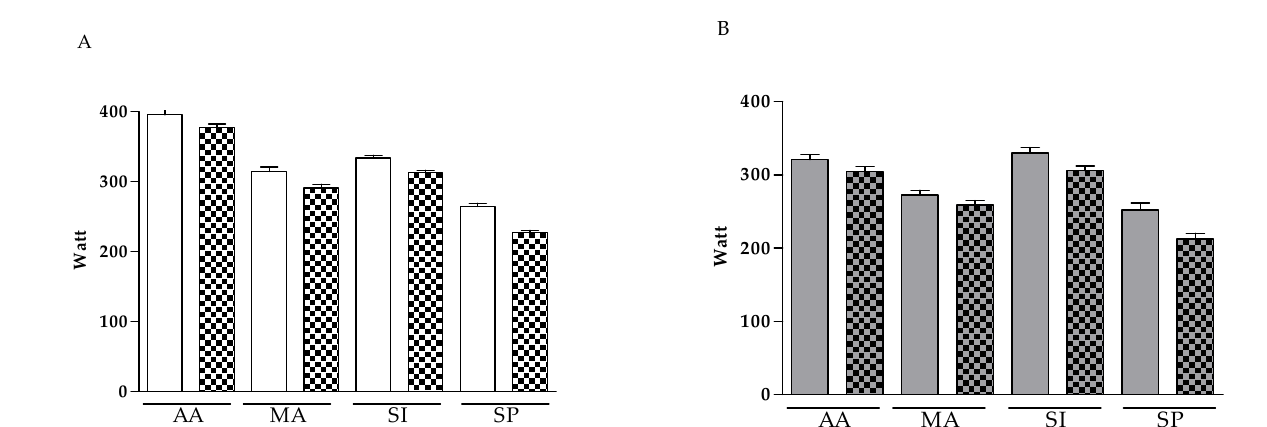
Figure 3. Incremental test. Statistical analyses were carried out on Jamovi software (version 2.3.18.0). Panel ( A ) refers to the data obtained in males; panel ( B ), in females. Empty bars refer to pre-COVID-19 while dotted bars refer to post-COVID-19. Before proceeding with the comparisons, the Shapiro– Wilk test for normality of distributions is performed. Along with comparisons, the Levene test for homogeneity of variances and Q-Q plots are evaluated. Comparisons are conducted with a repeated ANOVA measure, setting Pre vs. Post as the within factor, and group and sex as between factors. The Tukey correction for post hoc comparisons was applied. Partial eta squared ( η 2 p) was computed as effect size. p < 0.001 in all comparison.